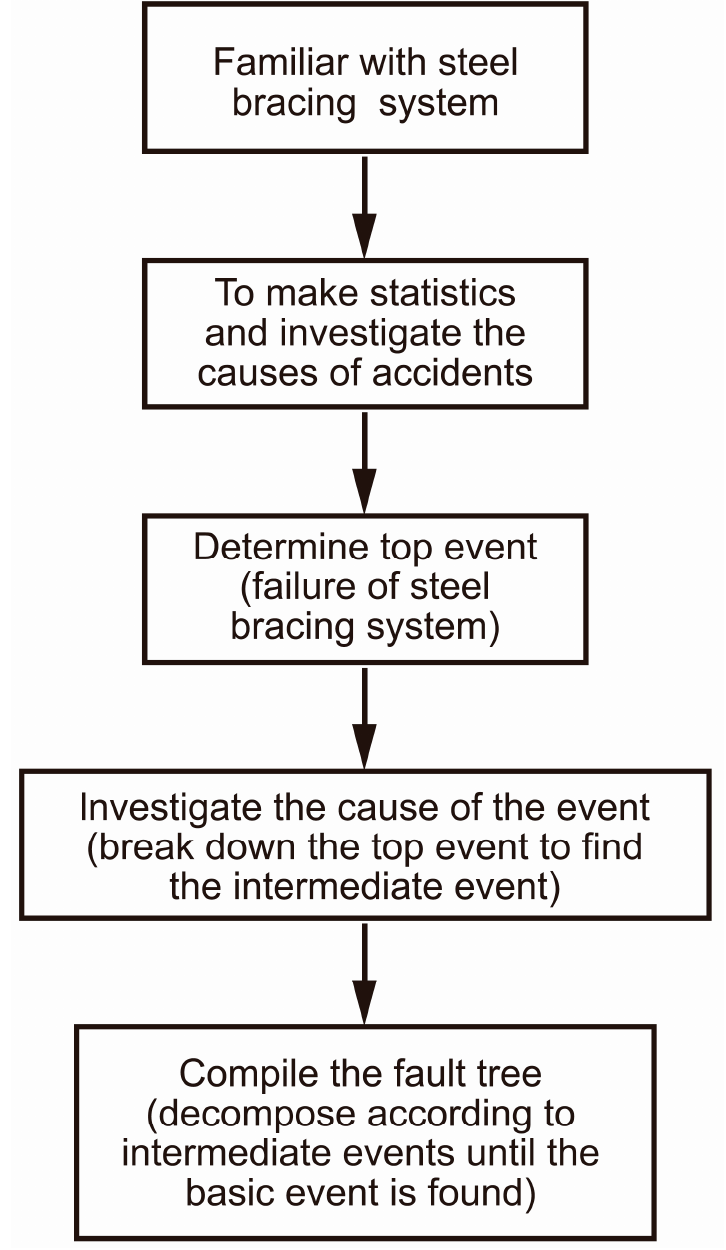
Figure 2. Accident tree preparation procedure.